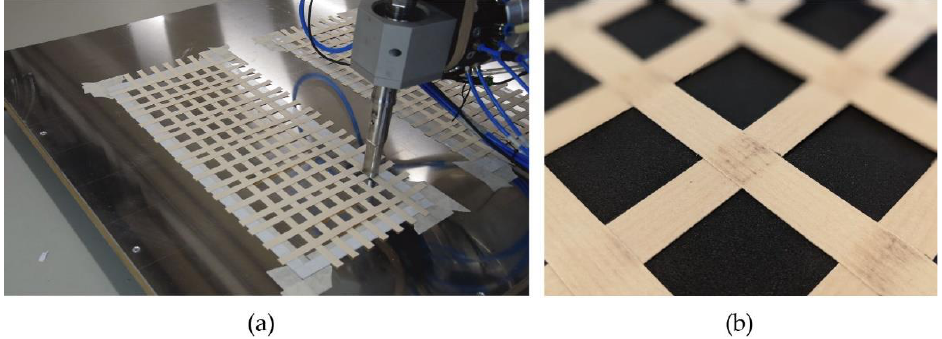
Figure 4. ( a ) Robotic welding process; ( b ) Welded intersection point close-up.